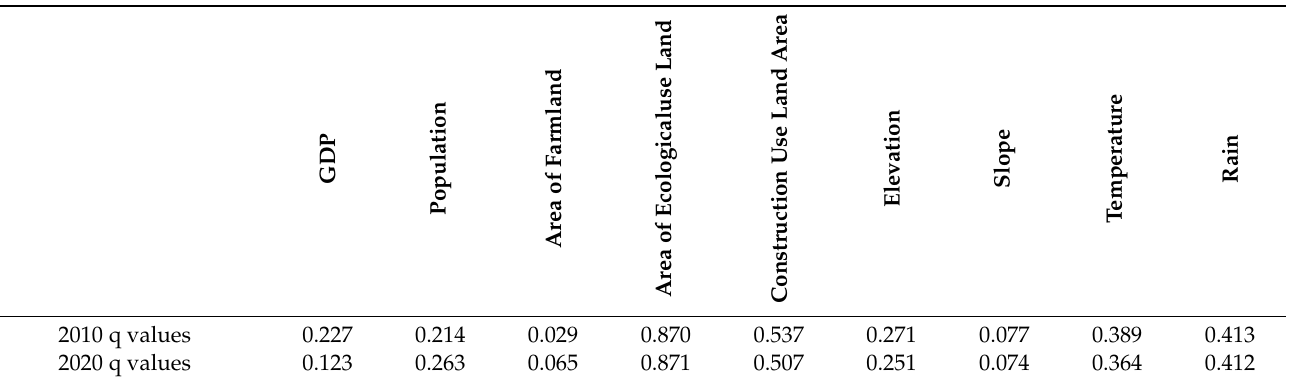
Table 3. Factor detection